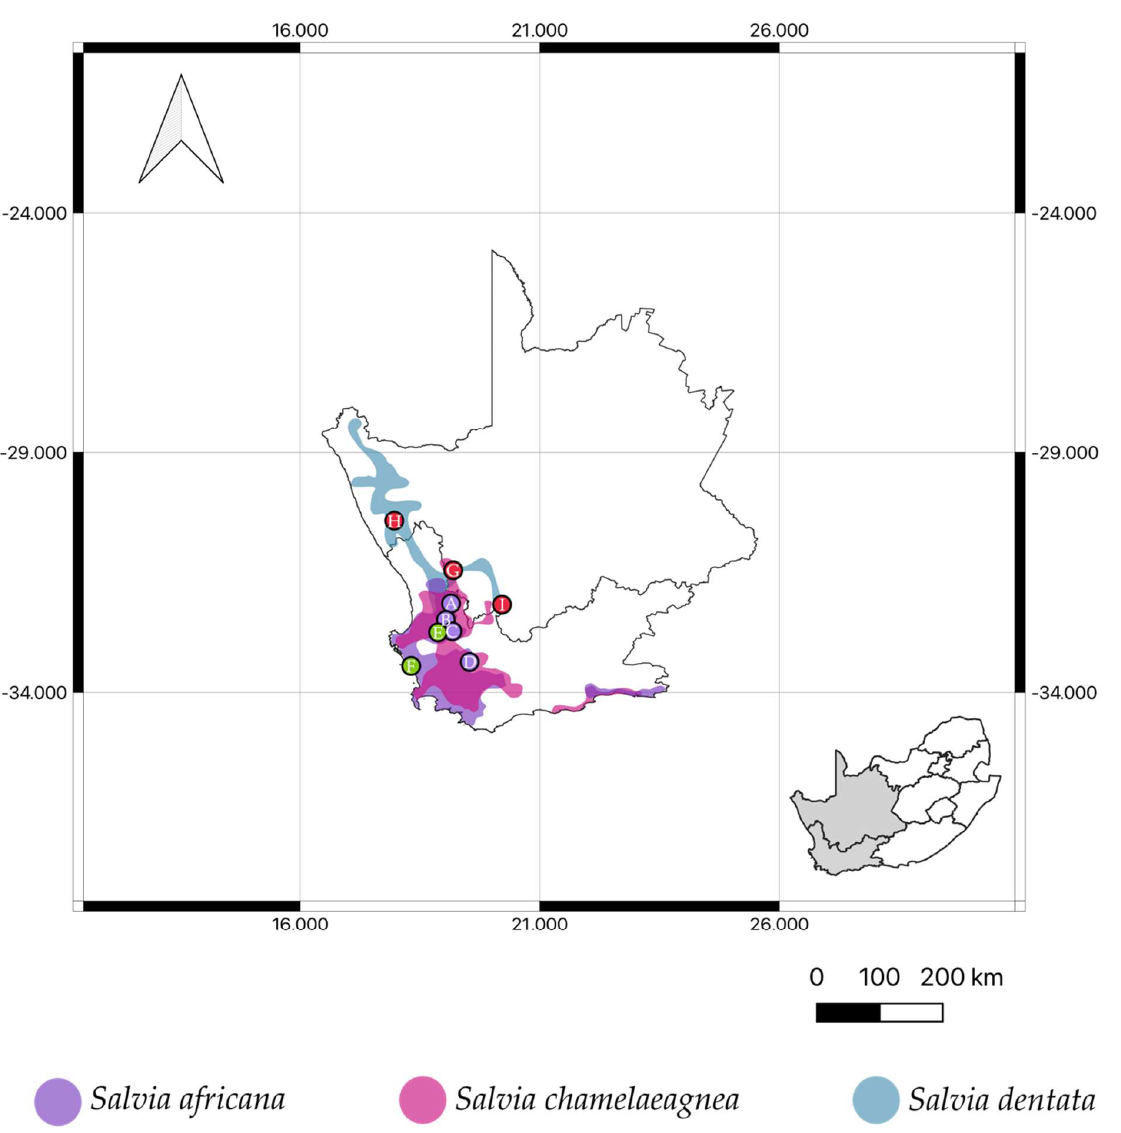
Figure 2. Distribution of the three medicinal, blue-flowered Salvia species in the Western and Northern Cape provinces of South Africa. Localities where plant materials were collected for analysis are numbered as in the material and methods section (data points A–I).